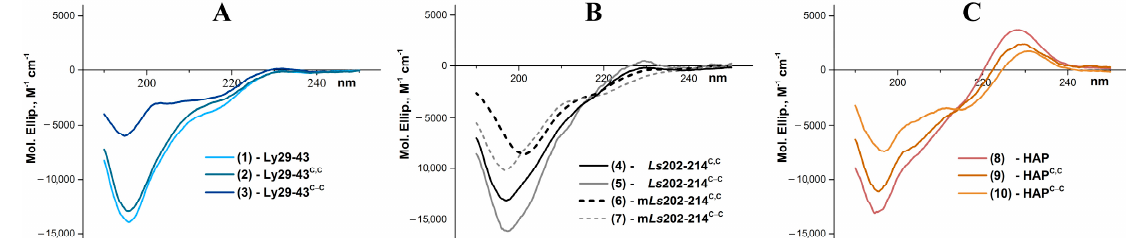
Figure 2. Characterization of secondary structure of peptides (1)–(10) at pH 7.5 by CD spectroscopy. ( A ) CD spectra of Lynx1 loop II fragments—Ly29–43, Ly29–43 C,C and Ly29–43 C-C . ( B ) CD spectra of native or mutated L. stagnalis AChBP loop C— Ls 202–214 C,C , Ls 202–214 C-C , m Ls 202–214 C,C , m Ls 202–214 C-C . ( C ) CD spectra of HAP and its analogs—HAP, HAP C,C and HAP C-C .